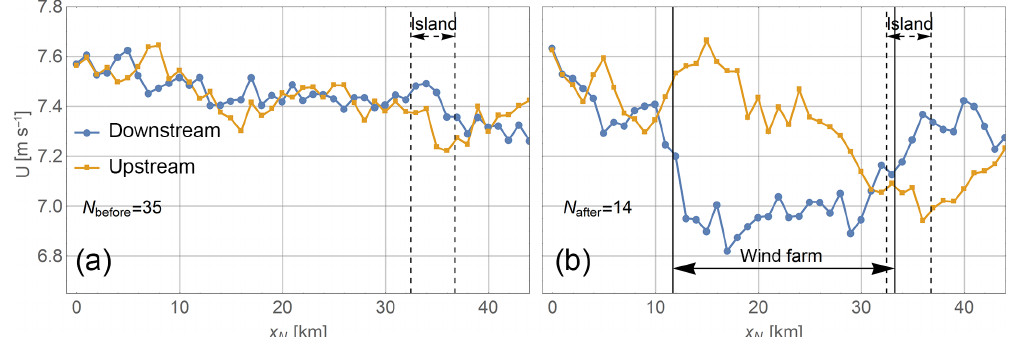
Figure 8. Wind speed transects from (a) before and (b) after wind farm construction for wind directions between 75 and 105 ◦ . Transect East is upstream and transect West is downstream of the (potential) wind farm location. The position of the wind farm to the east–west and Anholt Island to the east of the transects are